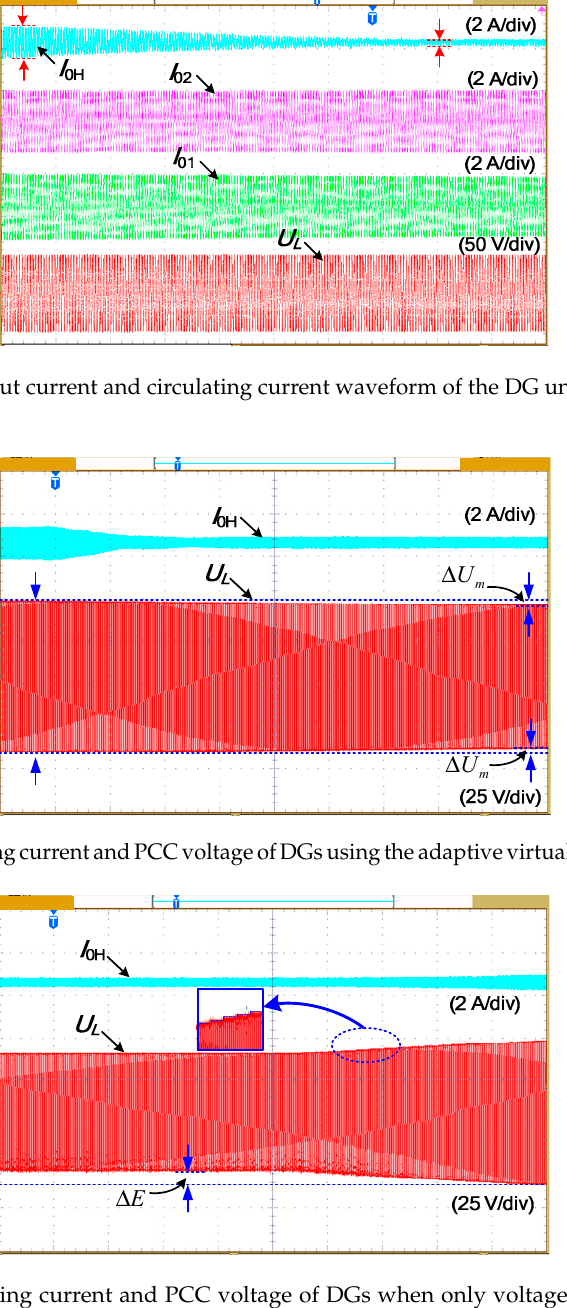
Figure 10. Steady state experimental waveforms using the proposed method.